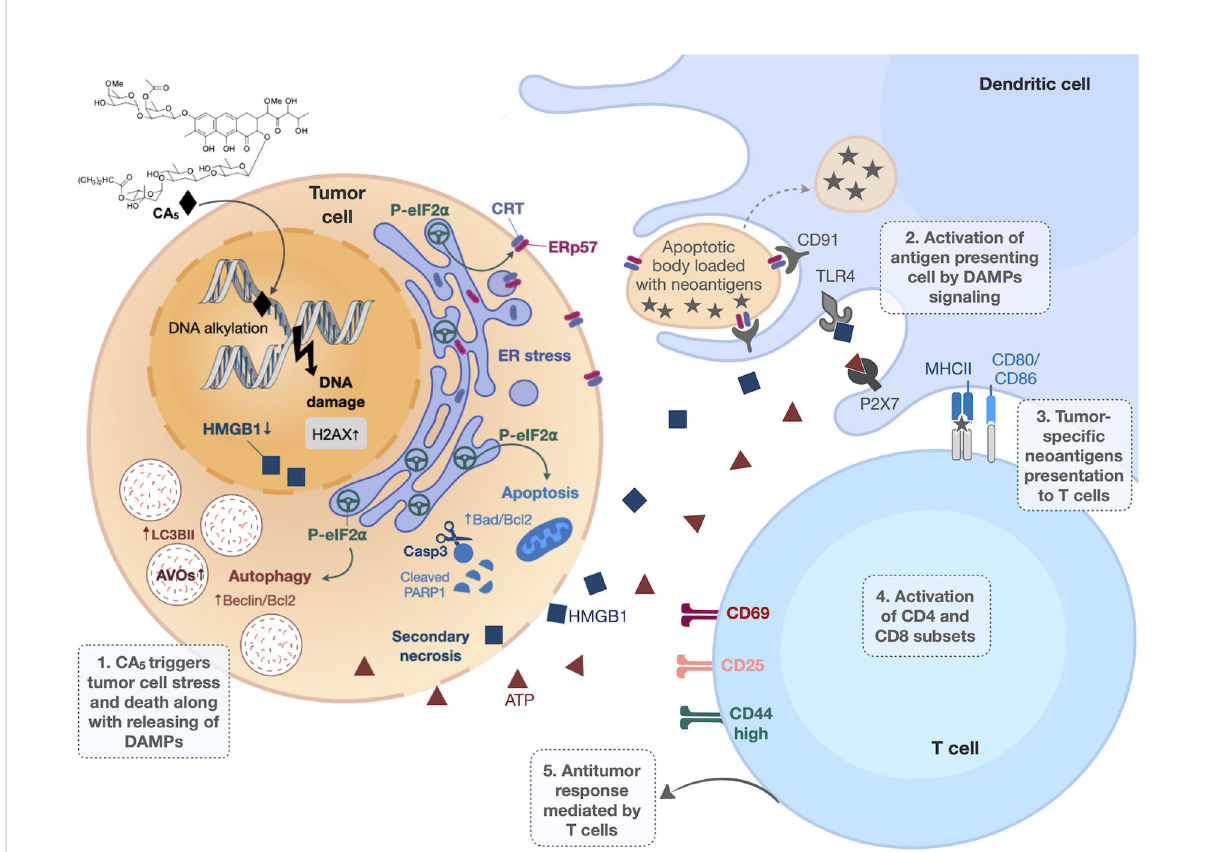
FIGURE 9 Overview of immunogenic cell death (ICD) induced by chromomycin A 5 (CA 5 ) on melanoma. B16-F10 cells treated with CA 5 displayed cell stress and cell death along with release of damage-associated molecular patterns (DAMPs). The phosphorylation of eIF2 a , due to endoplasmic reticulum (ER) stress, drives crucial immunogenic events, as externalization of the “ eat me ” signals calreticulin (CRT) and ERp57, autophagy and apoptosis. Dendritic cells are activated by DAMPs and present tumor antigens to T lymphocytes via MCH in the presence of co-stimulatory molecules (CD80 or CD86). The activation of T lymphocytes by dendritic cells confers antitumor response. AVOs, acidic vesicular organelles; Casp3, caspase 3; PRRs, pattern recognition receptors, HMGB1, high mobility group box 1; ATP, adenosine